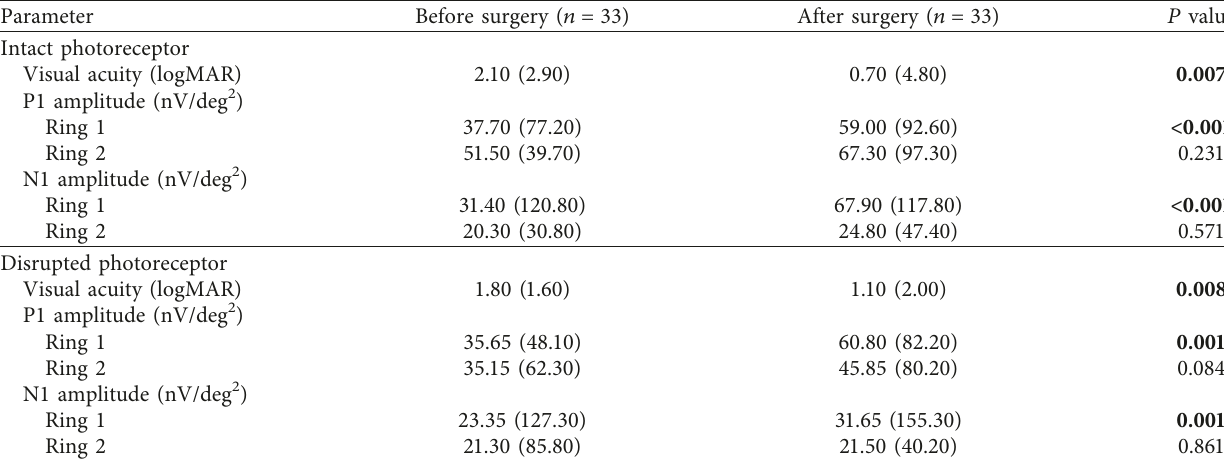
Table 2: Visual acuity and amplitude of P1 and N1 by photoreceptor status before and after surgery. Parameter Before surgery ( n � 33)